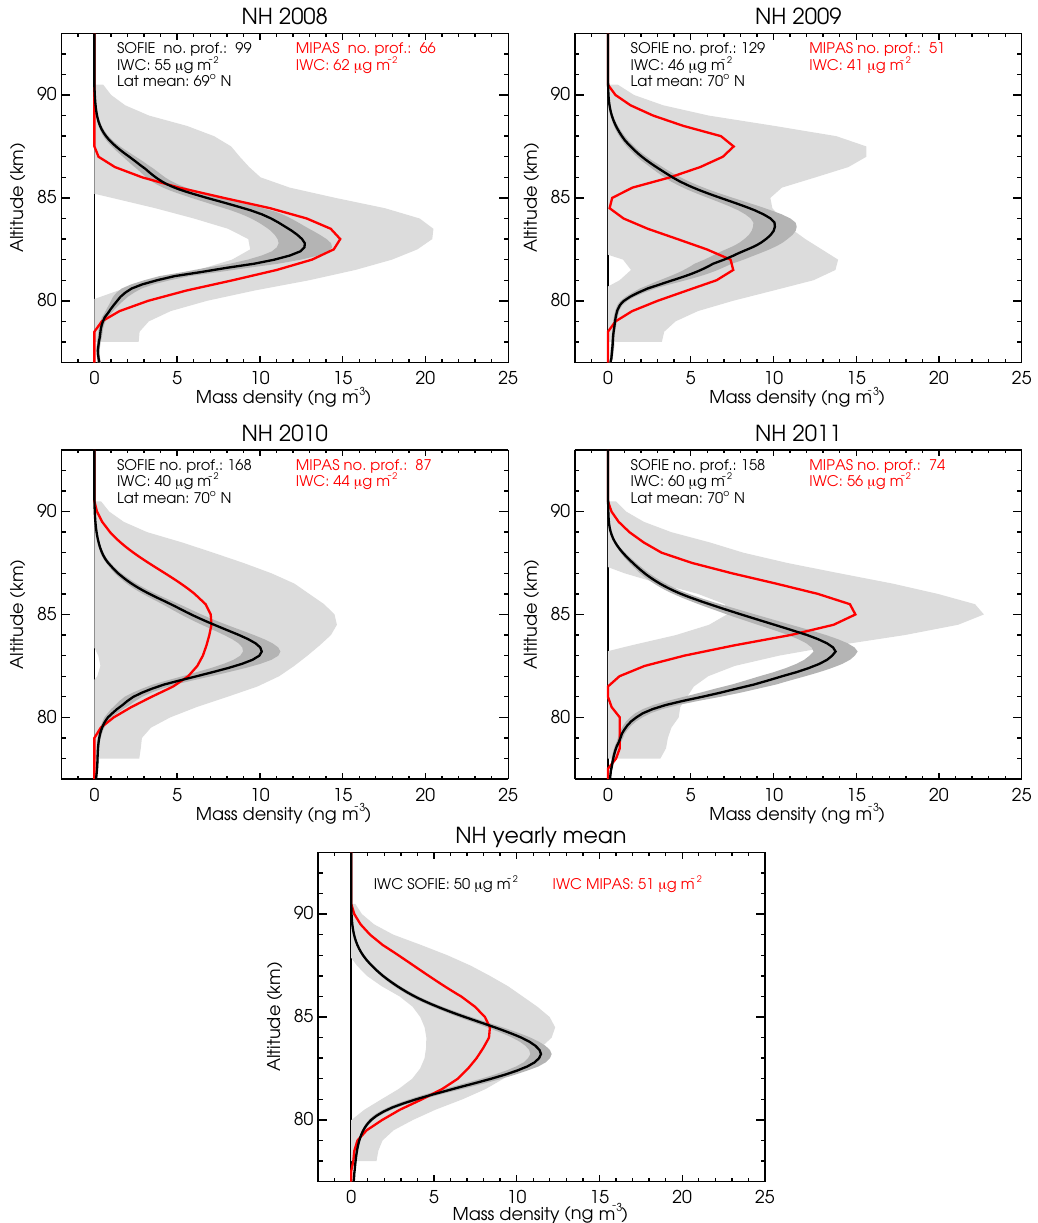
Figure 5. Comparison of the ice mass density of MIPAS MUA modes of measurements (see Table 1) with SOFIE v1.3 L2 data for the 2008 to 2011 period and the yearly mean (lower panel) in the NH. The solid lines show the mean profiles, SOFIE in black and MIPAS in red. The shaded areas are the standard deviations divided by the square root of the number of profiles. The means of the IWC are also